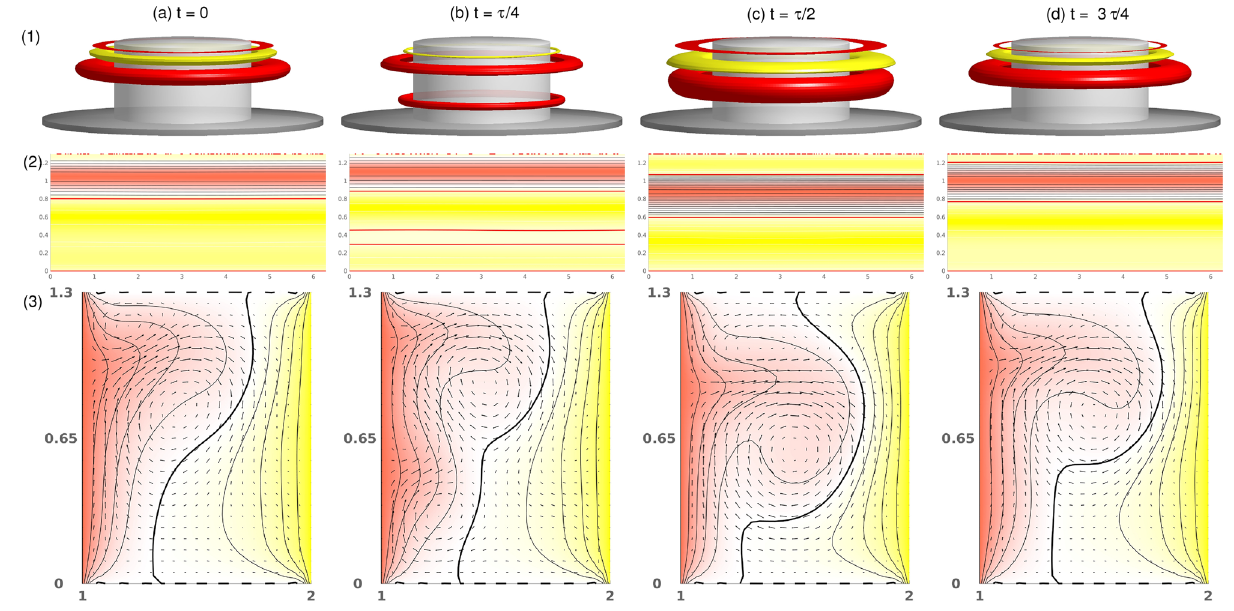
2 . As shown in Fig. 9 with isosurfaces = 0.405 . See also movie, movie_pV2_alpha2.avi, in SMs. Note the ≈ τ/ 4 =